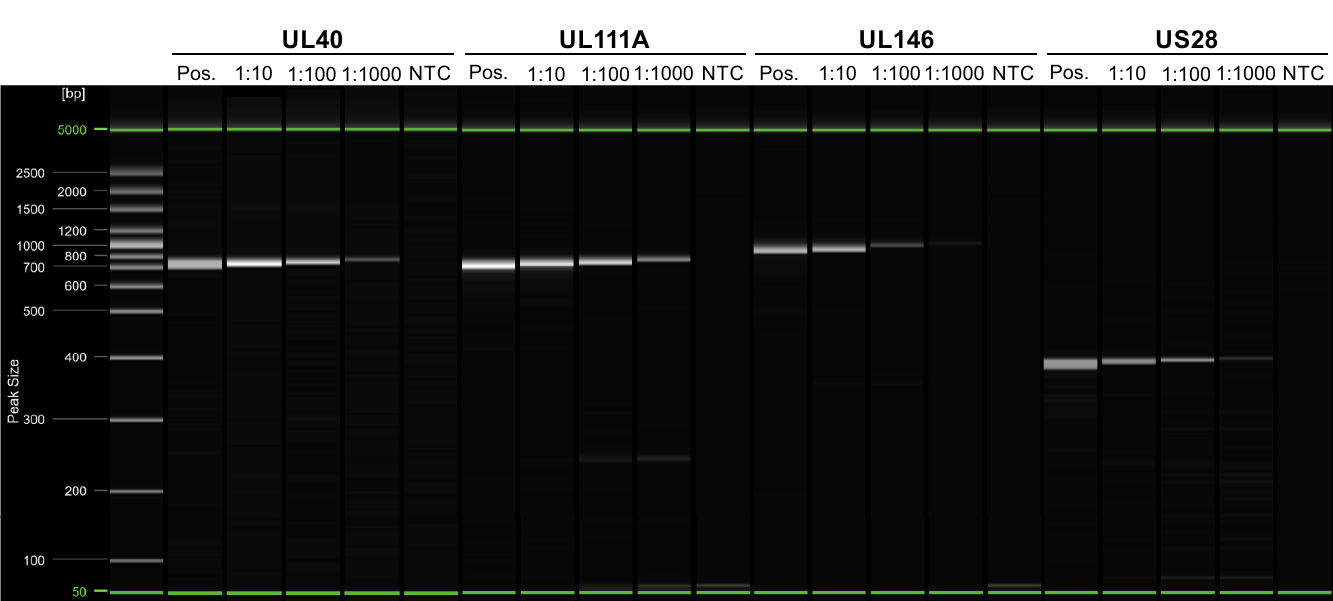
Fig 4. Specific PCRs for UL40, UL111A, UL146, and US28 on DNA extracted from DBSs. PCR amplification from positive sample (amniotic fluid, 100,000,000 cp/ ml, Pos.), treatment D extractions from filter paper discs (1:10, 1:100, and 1:1,000 dilution; 8,500–850,000 cp/ml), and no template control (NTC). Gel representation of capillary electrophoresis reads (S1 File). Green lines represent the alignment marker used for calibration of band sizes.